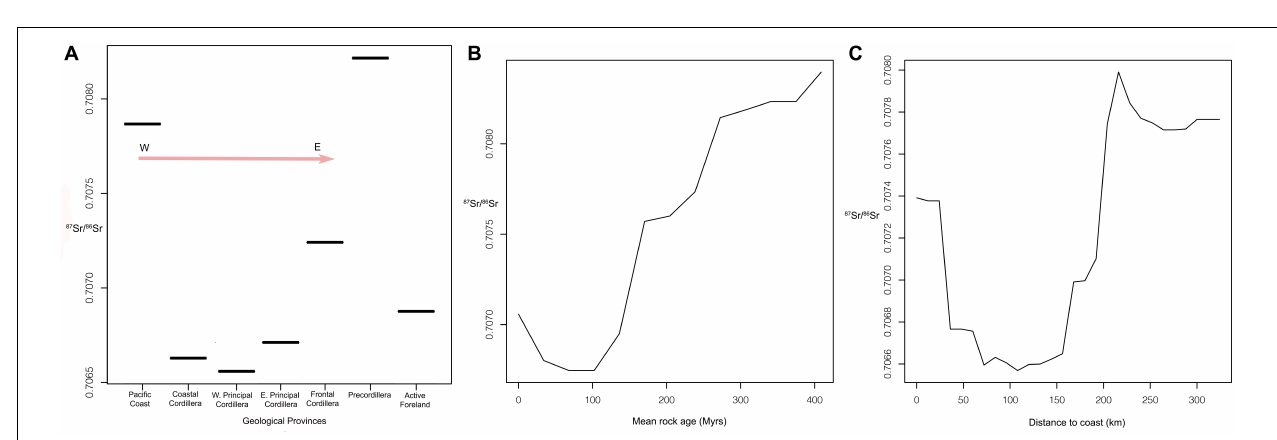
FIGURE 7 | Analysis of partial dependence between the variables of the Random Forest models and 87 Sr/ 86 Sr values for the “Rodents” model. Key: (A) geological province, (B) mean rock age (years), and (C) distance to coast (km).